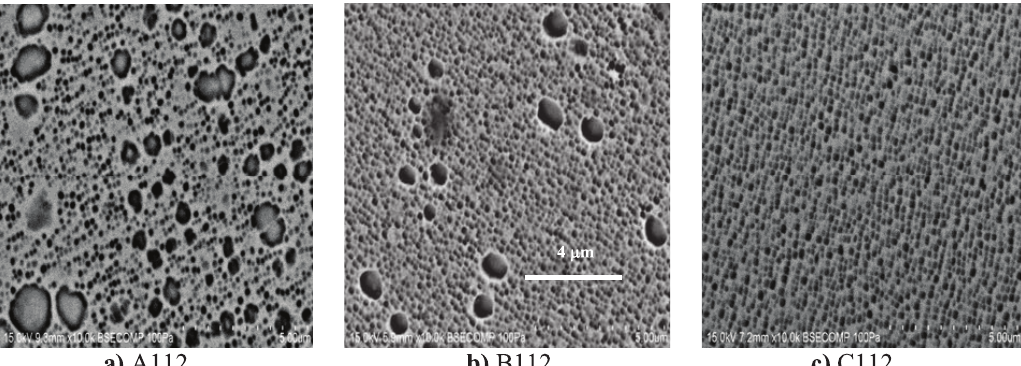
Figure 23. Microstructures of specimens after reheat treatment of Program 9. 3.7 Microstructures of A31-B31-C31, A211-B211-C211, A121-B121-C121 and